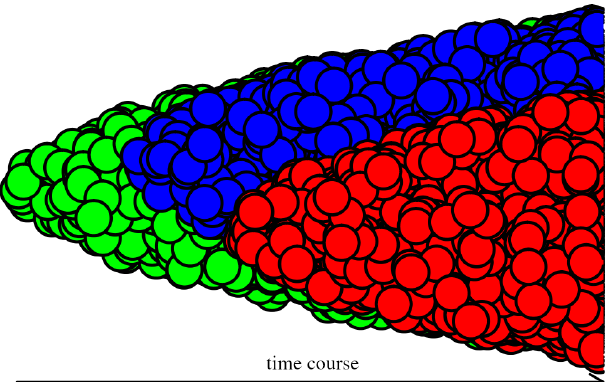
Figure 1. Simplified model of cancer evolution. The new clone originates by mutation(s) from the original